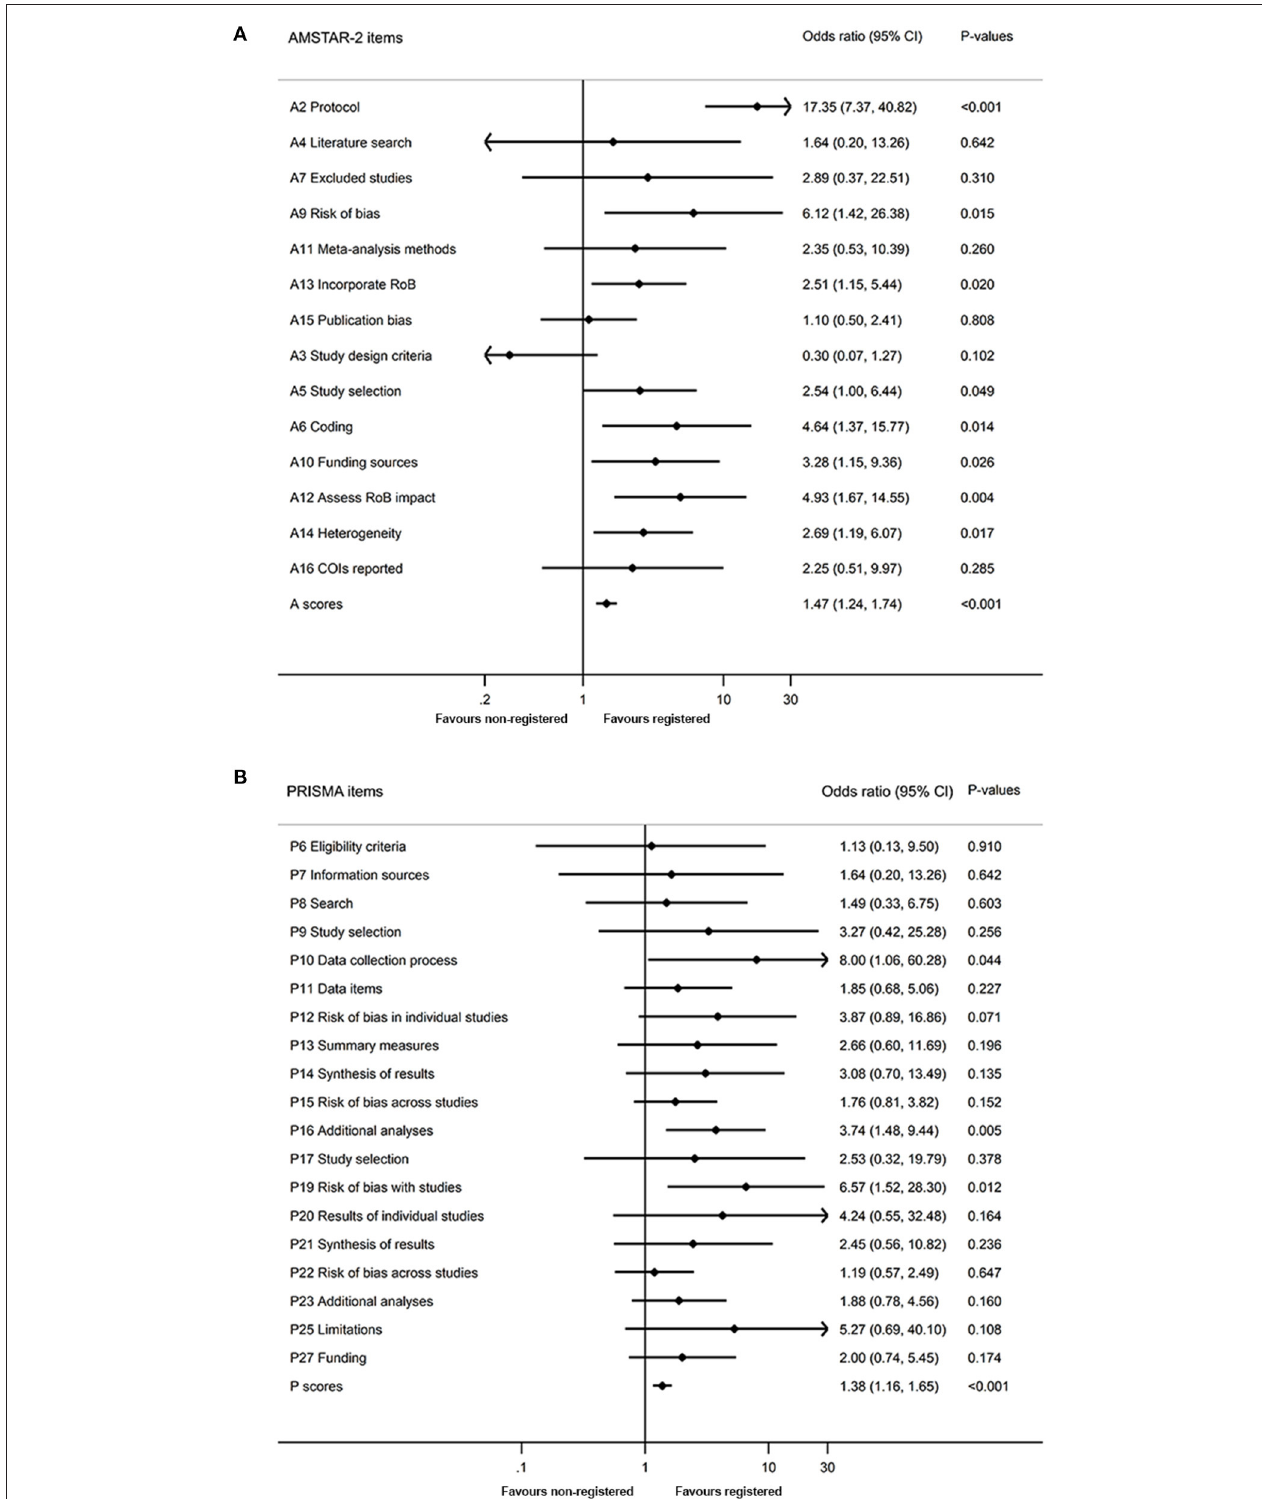
FIGURE 4 | Comparison of quality between registered and non-registered reviews. (A) Comparison of methodological quality between registered and non-registered reviews. (B) Comparison of reporting quality between registered and non-registered reviews. A, Assessment of Multiple Systematic Review 2; P, Preferred Reporting Items for Systematic Reviews and Meta-analyses; RoB, risk of bias; COI, conflicts of interest.